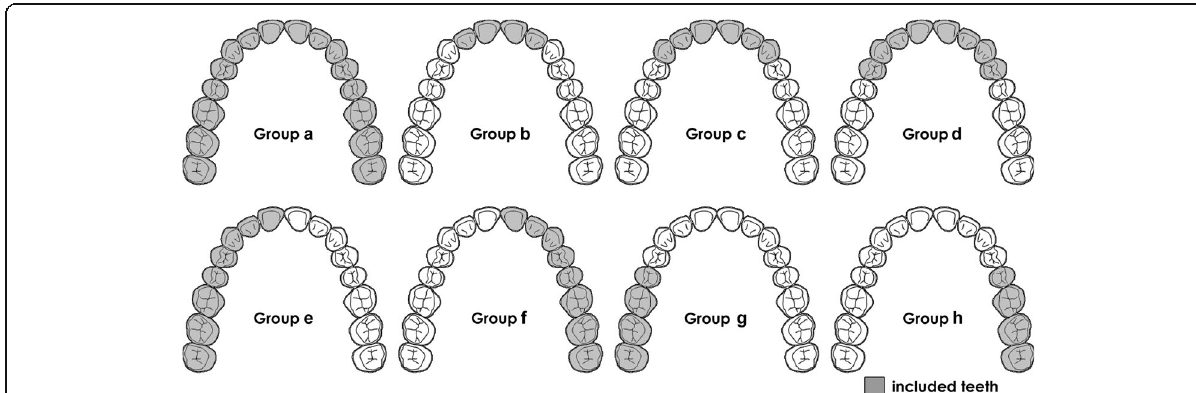
Fig. 5 Group s for superimposing the 3D dataset of the dental casts in experiment 1. Full arch ( a ); partial arch from the left to the right second incisor ( b ), the left to the right canine ( c ), the left to the right first premolar ( d ), the right central incisor to the right last molar ( e ), the left central incisor to the left last molar ( f ), the right second premolar to the right last molar ( g ), and the left second premolar to the left last molar ( h )